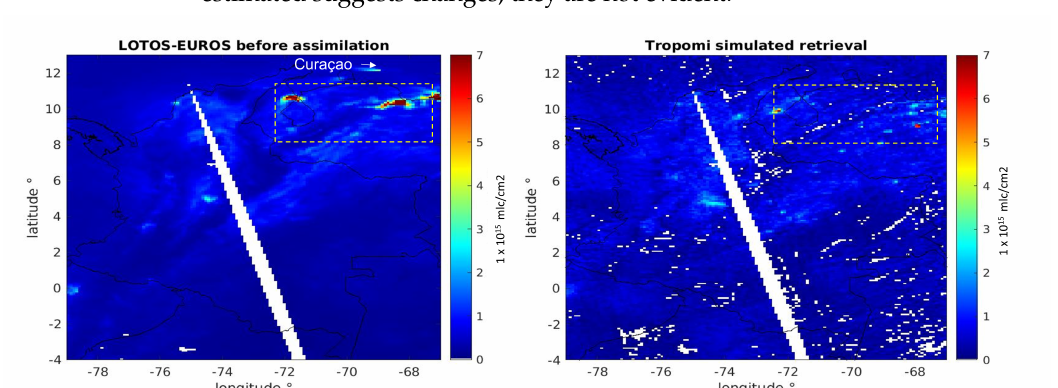
Figure 7. Comparison of the tropospheric NO 2 column estimation from LOTOS-EUROS simulations ( left ) and TROPOMI retrievals ( right ) for 2 February 2019. The dashed rectangle highlights the sizable discrepancies between the two sources observed over the main Venezuelan cities (Caracas, Valencia, Barquisimeto, and Maracaibo).